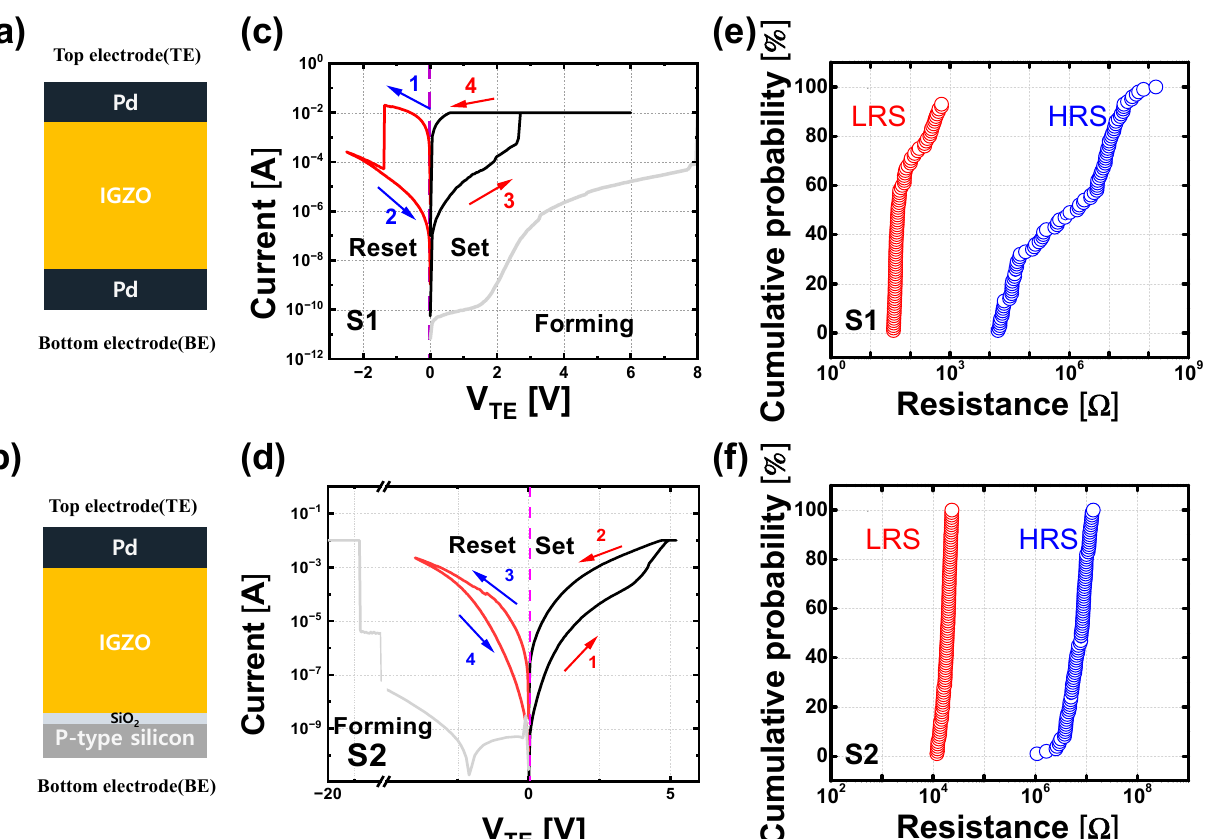
Figure 1. ( a , b ) Schematic view and ( c , d ) electrical switching I – V characteristics of S1 and S2 with a feature size of 10 μ m. ( e , f ) Cumulative probability plot for both HRS and LRS of S1 and S2 measured at 0.1 V.